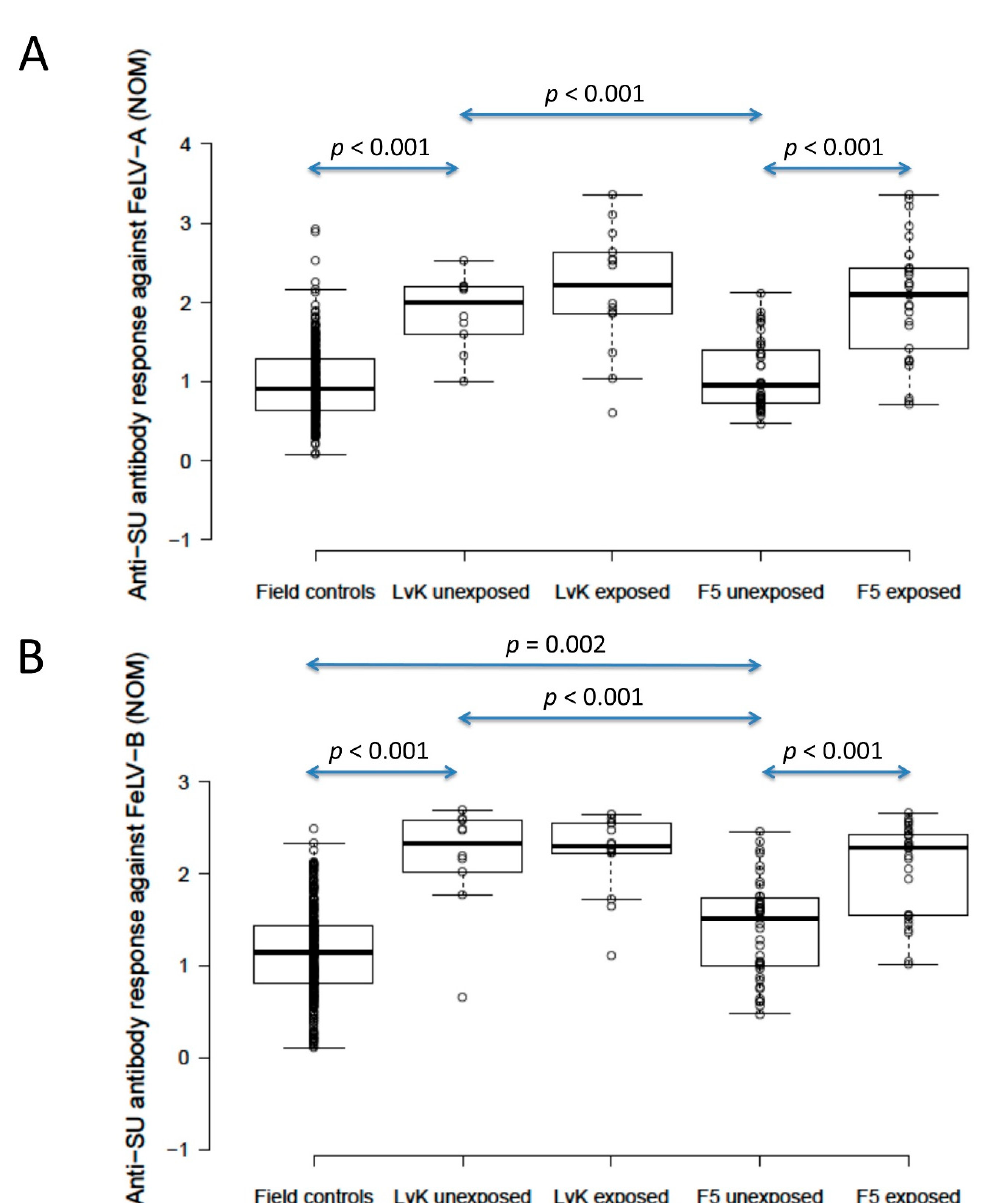
Figure 4. Comparison of anti-SU antibody ELISA responses to examine the effect of FeLV vaccination and natural exposure to FeLV following vaccination (( A ) anti-FeLV-A SU antibody ELISA results, ( B ) anti-FeLV-B SU antibody ELISA results). The field control group consisted of unvaccinated and unexposed cats ( n = 303) and is included to provide a baseline. Ten unexposed cats had been vaccinated on-time with Fel-O-Vax ® Lv-K and 40 unexposed cats had been vaccinated on-time with Fel-O-Vax ® 5. In total, 43 vaccinated/uninfected cats had been exposed to FeLV (abortive infections), including 14 cats vaccinated with Fel-O-Vax ® Lv-K and 29 cats vaccinated with Fel-O-Vax ® 5. Statistically significant differences in median NOD values between vaccinated groups after exposure are shown. The monovalent vaccine (Fel-O-Vax ® Lv-K) induced significantly higher antibody levels in unexposed cats against both FeLV-A and FeLV-B SU than the polyvalent vaccine (Fel-O-Vax ® 5) ( p < 0.001 for both; Mann–Whitney U -tests). Cats vaccinated with the polyvalent Fel-O-Vax ® 5 vaccine and exposed to FeLV displayed a booster effect of natural FeLV exposure ( p < 0.001 for both FeLV-A and FeLV-B SU; Mann–Whitney U -tests); cats vaccinated with the monovalent Fel-O-Vax ® Lv-K vaccine and exposed to FeLV displayed no such booster effect ( p = 0.33 for FeLV-A and p = 0.82 for FeLV-B; Mann–Whitney U -tests). Data points are plotted as open circles, centre lines show the medians, box limits indicate the 25th and 75th percentiles, and whiskers extend 1.5 times the interquartile range from the 25th and 75th percentiles. NOD = normalised optical density, SU = surface unit, LvK = Fel-O-Vax ® Lv-K, F5 = Fel-O-Vax ® 5.